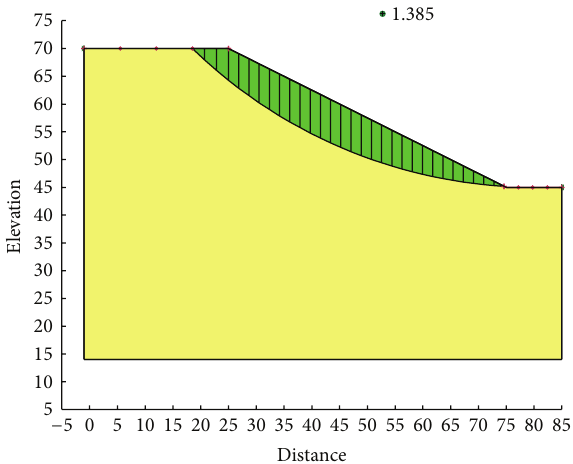
Figure 10: Critical failure surface with the Morgenstern-Price method.